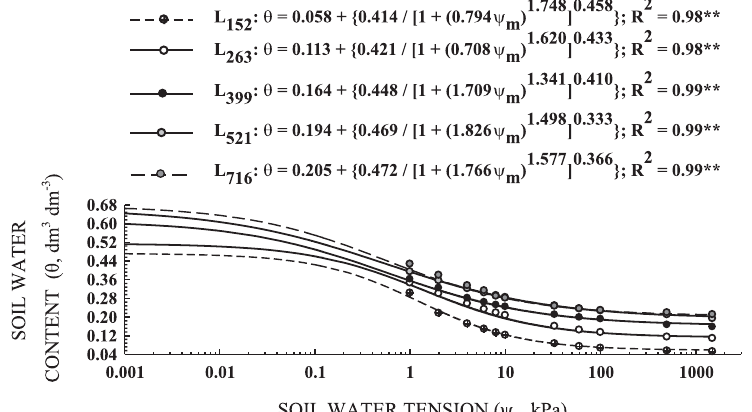
Figure 3. Typical water curve [water content in soil ( θθθθθ ) as a function of water tension in soil ( ΨΨΨΨΨ (L) in the county of Rio Verde, GO. Subscript numbers of Latosols correspond to the respective clay content (g kg -1